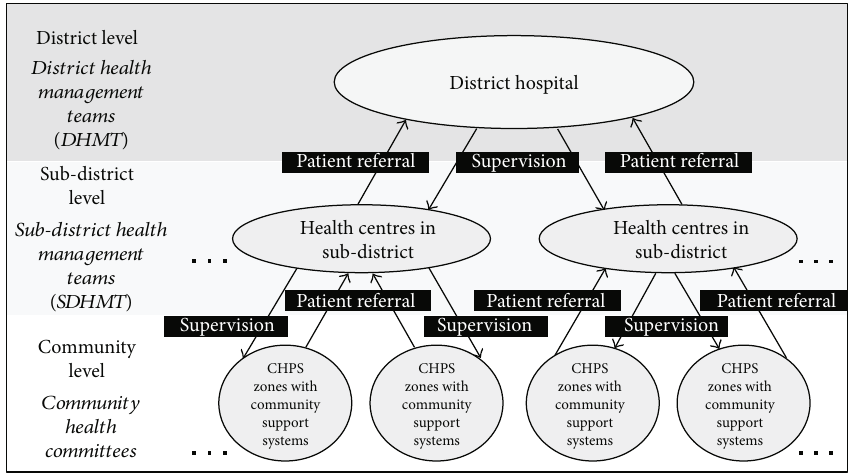
Figure 1: Levels of primary healthcare services in the districts in